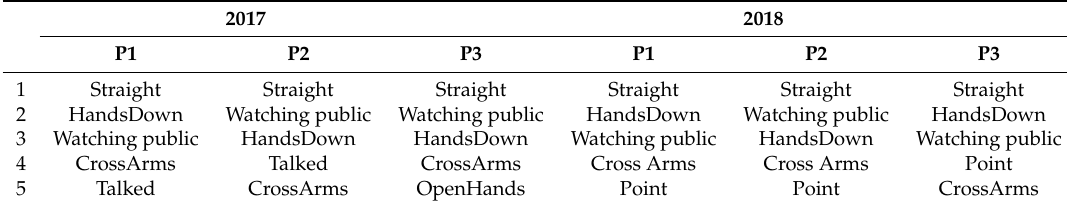
Table 4. The top 5 attributes for each